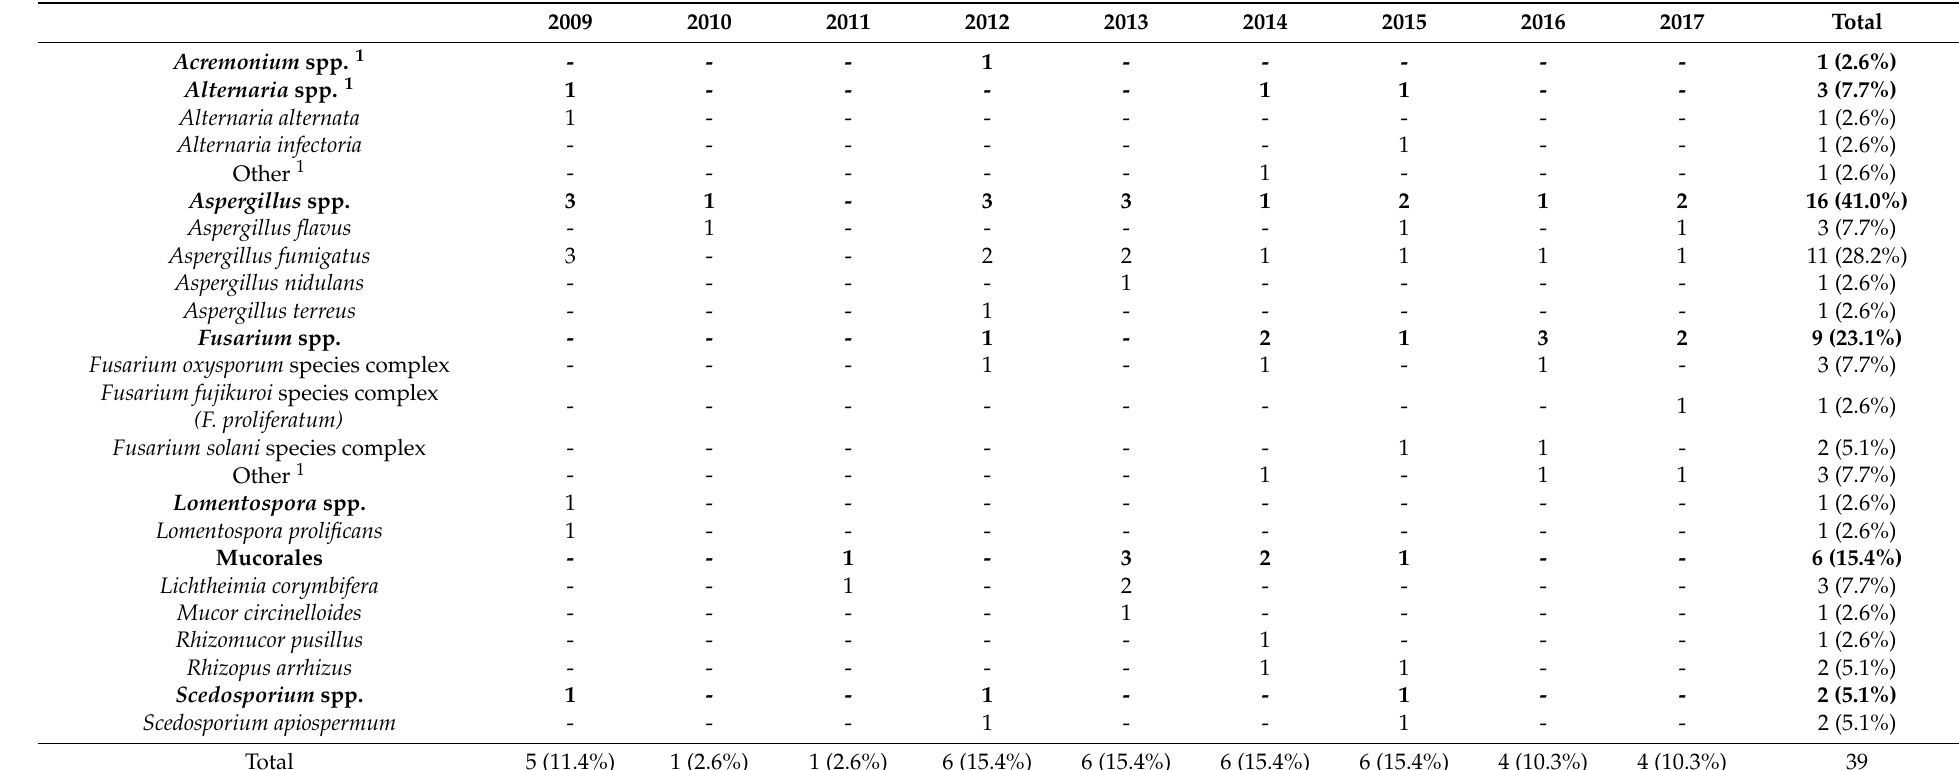
Table A2. Spectrum of isolated filamentous fungi auricular, ocular, deep cutaneous, and sinus localized infections per